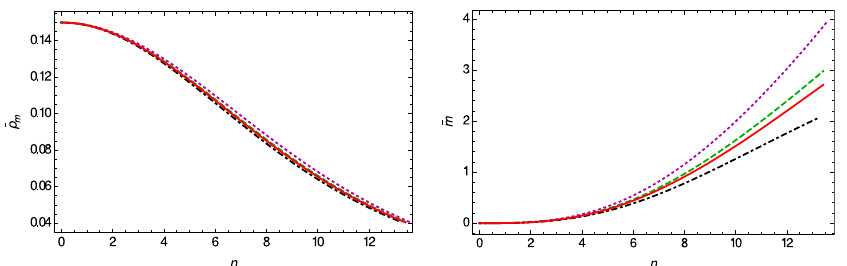
Fig. 1 Theinteriormass–energy-densityprofile ¯ ρ m (leftpanel)andthe massprofile ¯ m (right figure)asafunctionofthedistancefrom thecenter of the three-form stiff-fluid stars η , in the presence of a constant field potential, for three different values of the constant ¯ λ : ¯ λ = 0 (dashed